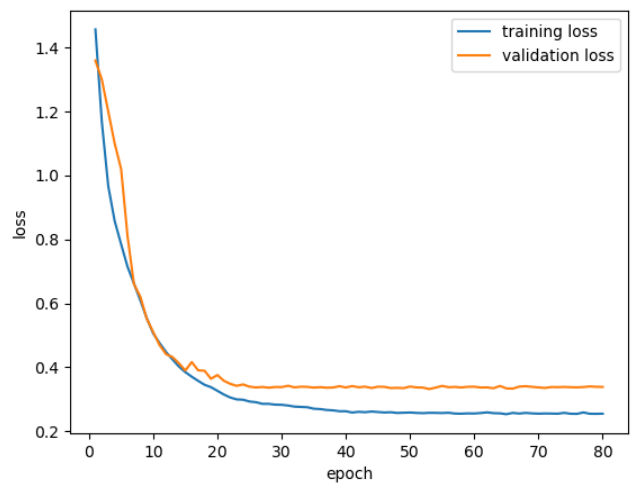
Figure 5. Training and validation loss curves for m1ulti-object semantic segmentation of BUS images.